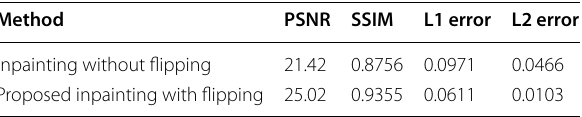
Table 2 Quantitative comparison between the baseline inpainting method without flipping and the proposed inpainting